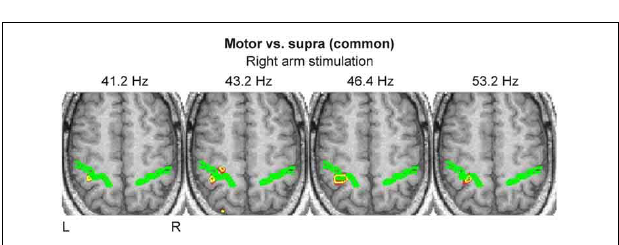
FIGURE 5 | Spatio-frequency grand activation maps derived from “Motor vs. Supra” contrast are shown for right arm stimulation at four frequencies (indicated on top of each image). The same conventions as in Figure 4 are used.